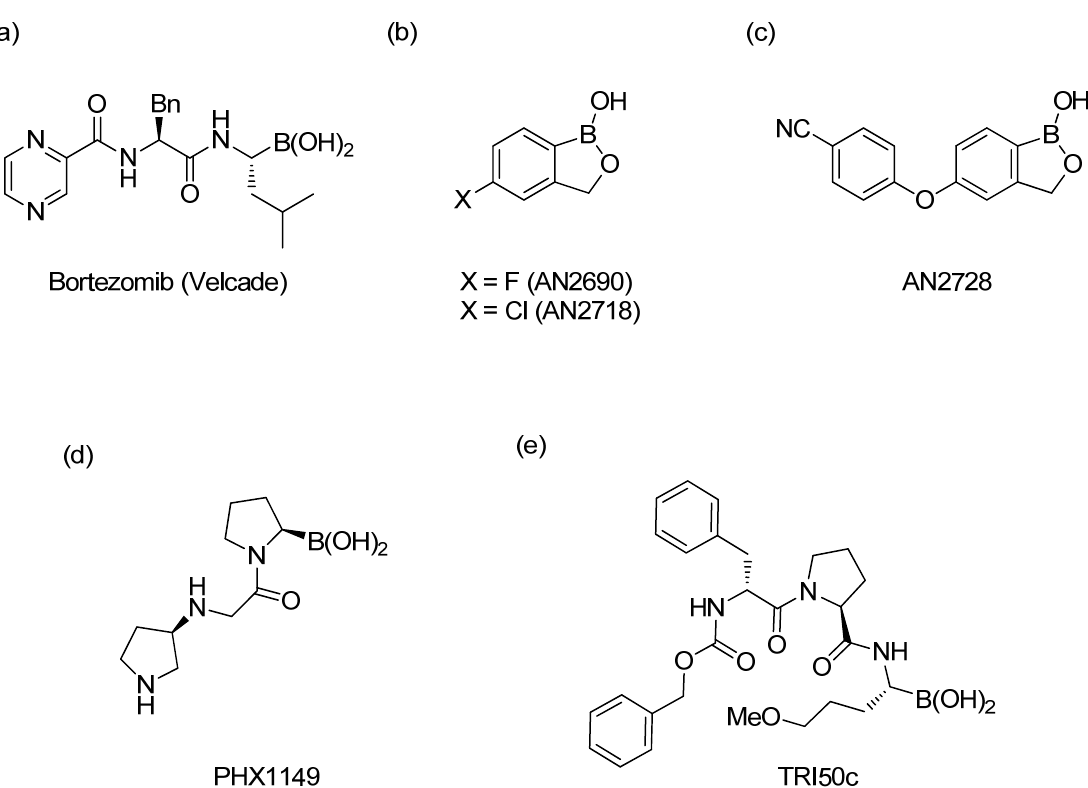
Figure 1. Boron-containing analogs as pharmaceutical